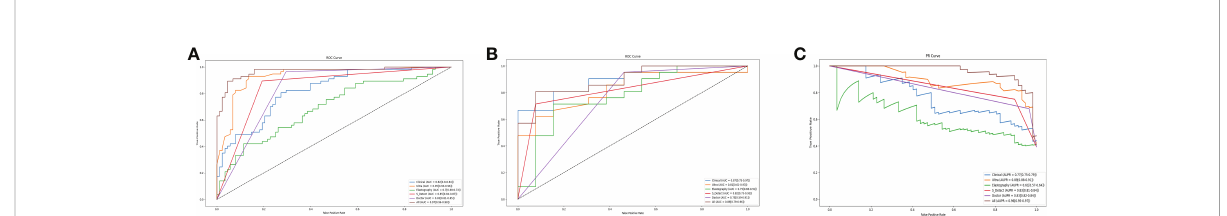
FIGURE 2 The ROC Curves in training set (A) . The ROC Curves (B) and the PR Curves (C) independent test set of the models based on the selected features. Clinical presents the model built with clinical features. Ultra presents the model built with ultrasonic features. Elastography presents the model built with elastography features. All present the model build with the combined features (clinical, ultrasonic, elastography,